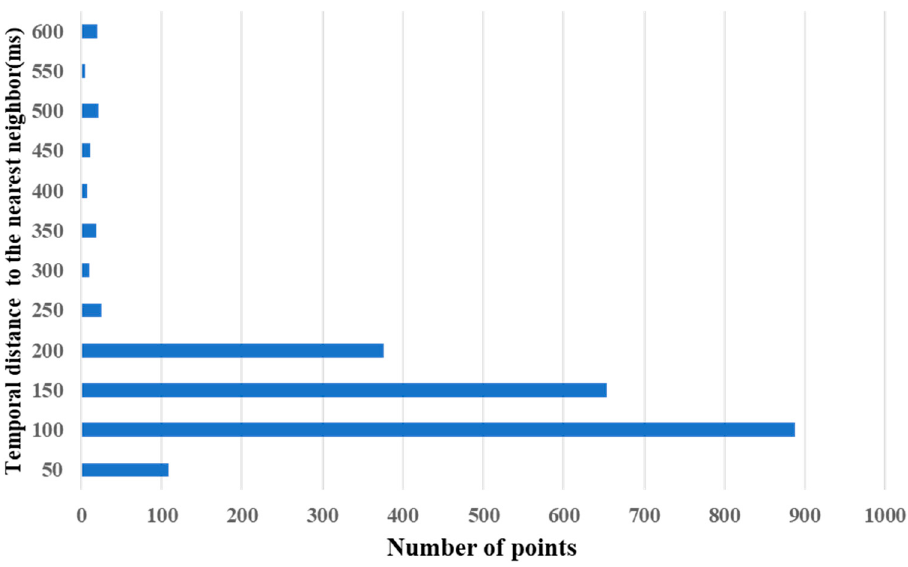
Figure 13. Histogram for estimating temporal Eps parameter.